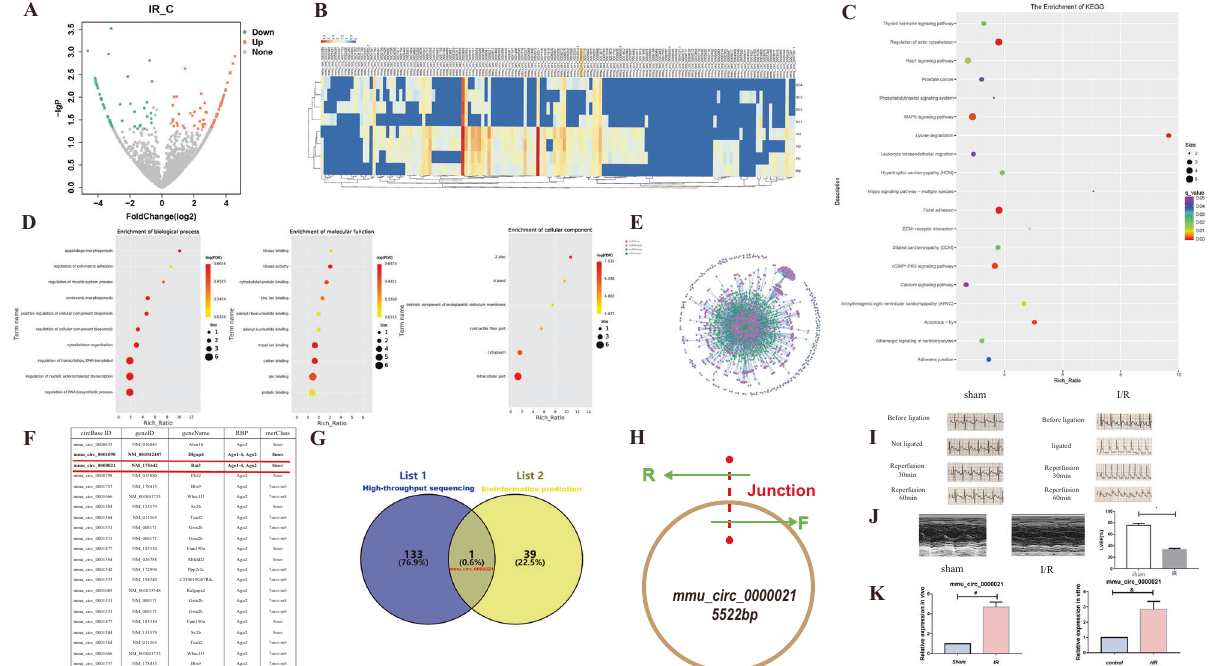
Fig. 1 Screening for differentially expressed circRNAs. A Volcano map of up-regulated or down-regulated differentially expressed circRNAs. B Heatmap illustrating differentially expressed genes identi fi ed by high-throughput sequencing. C , D GO and KEGG analysis analyses were performed using Clusterpro fi ler. E Cytoscape software was used to visualize an interaction network based on miRNA and circuRNA interaction data. F Starbase shows the predicted circRNA and miR-143-3p. G The Venn diagram illustrates the common gene target between bioinformatics prediction and circRNA sequencing. H CircRNA that exhibits a ring structure. I ECG recordings were analyzed for different periods. J Echocardiography was used to evaluate cardiac function in mice. K Changes in mmu_circ_0000021 in vivo and in vitro models were tested by qRT-PCR. # P < 0.05 compared with the sham group; & P < 0.05 compared with the control group; n =